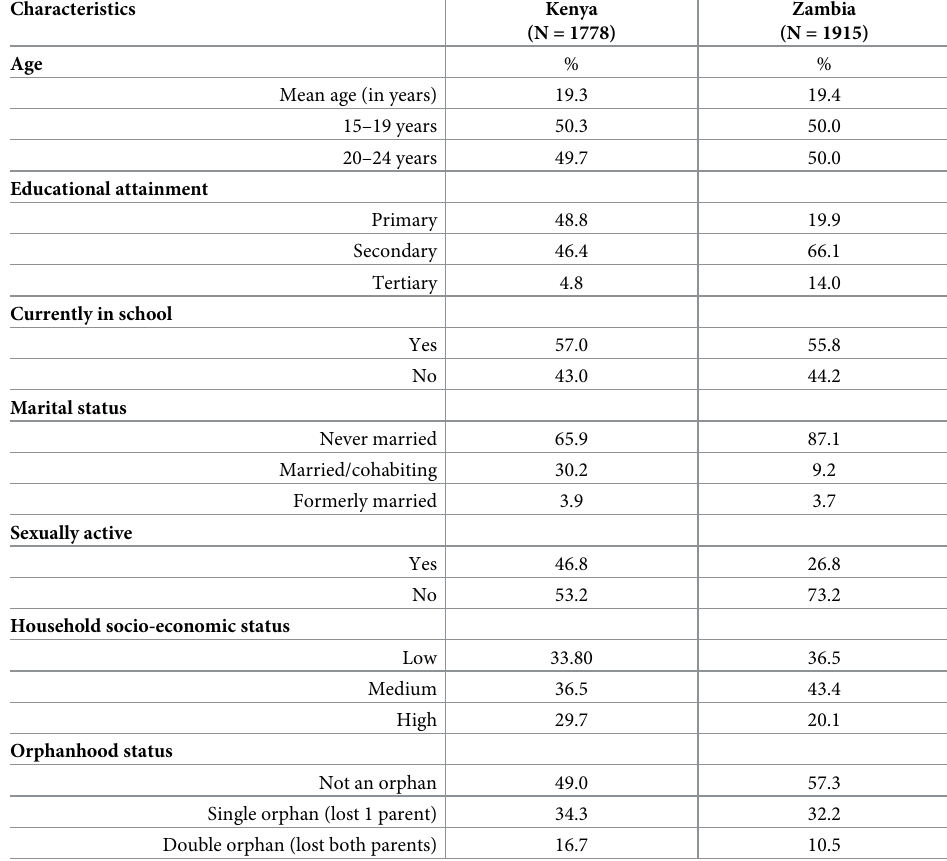
Table 1. Socio-demographic characteristics of respondents, Kenya and Zambia.